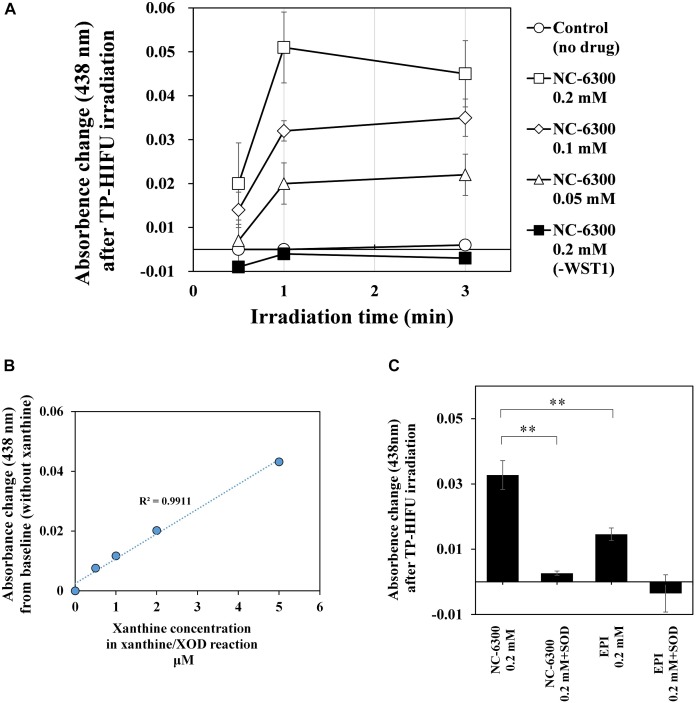
Measurement of the amount of superoxide anions by UV spectrophotometer. The sample solution containing 0.2 mM WST-1 and the indicated concentration of NC-6300 or EPI (as EPI concentration) was irradiated by TP-HIFU. (A) TP-HIFU irradiation to NC-6300 in various concentration and at different irradiation times. (B) Correlation with xanthine concentration in xanthine/xanthine oxidase reaction and absorbance change at 438 nm. (C) Comparison of the generation of superoxide anion with NC-6300 and EPI. Superoxide dismutase (SOD) was added to confirm generation of the superoxide anion. The absorbance change was measured at 438 nm and that of non-irradiated sample was subtracted. The irradiation groups were collected as three samples and presented as the mean ± standard deviation. ∗∗P < 0.01, comparison for each pair by Tukey–Kramer test.